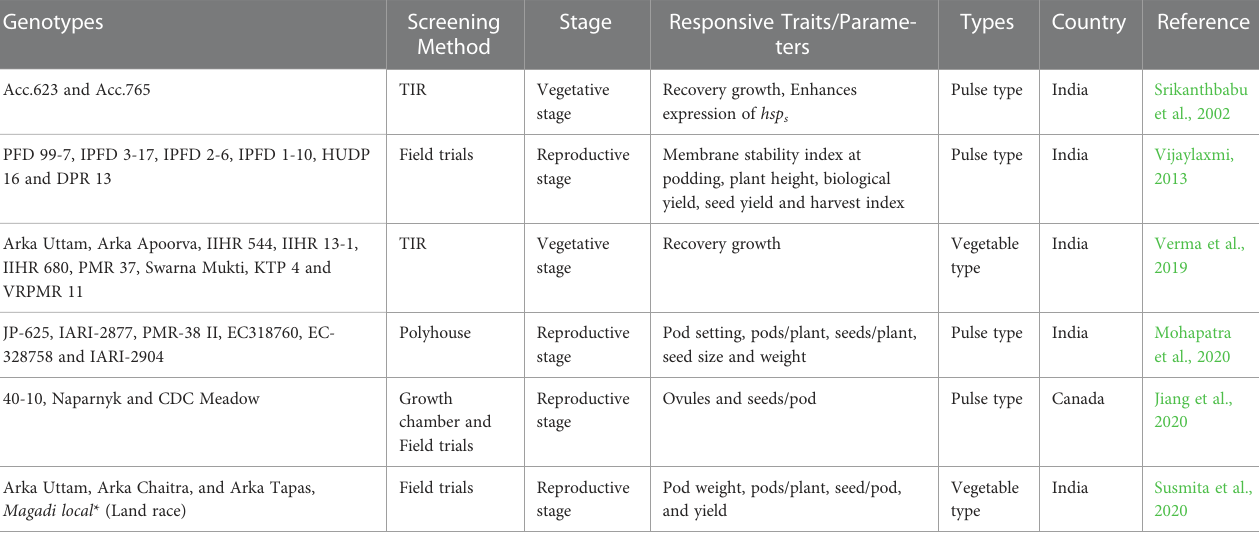
TABLE 2 List of pea genotypes identi fi ed for heat tolerant and their associated traits.